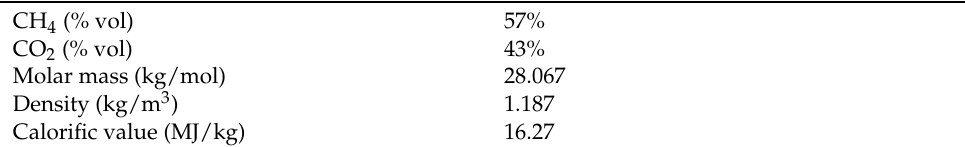
Table 4. The composition and thermodynamic parameters of biogas